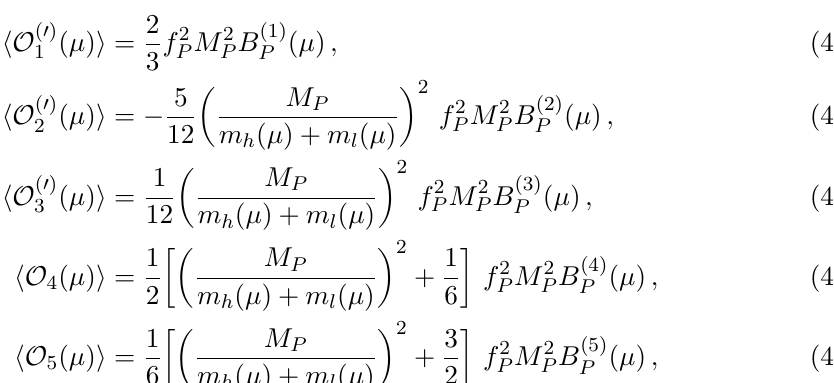
Table 2 . Bag parameters calculated within lattice QCD, adapted from refs. [230, 231]. The renormalization scale is µ = { 3 , 3 , 4 . 18 , 4 . 18 } GeV for P = { K 0 , D 0 , B d , B s } . where hO i ( µ ) i ≡ h P 0 |O i ( µ ) | ¯ P 0 i can be expressed in terms of non-perturbative “bag param- eters” B ( i ) (see e.g. ref. P